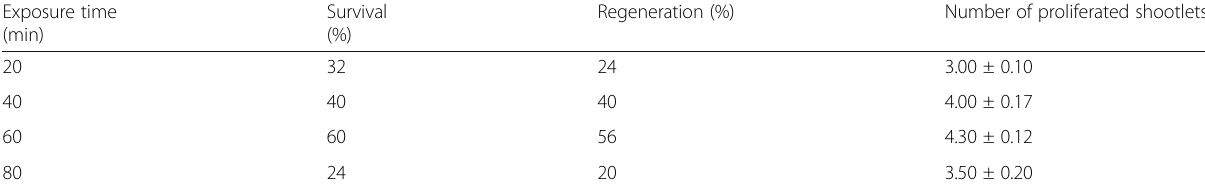
Table 2 Effect of exposure time to PVS2 on recovery of cryopreserved shoot apices of globe artichoke Exposure time (min)